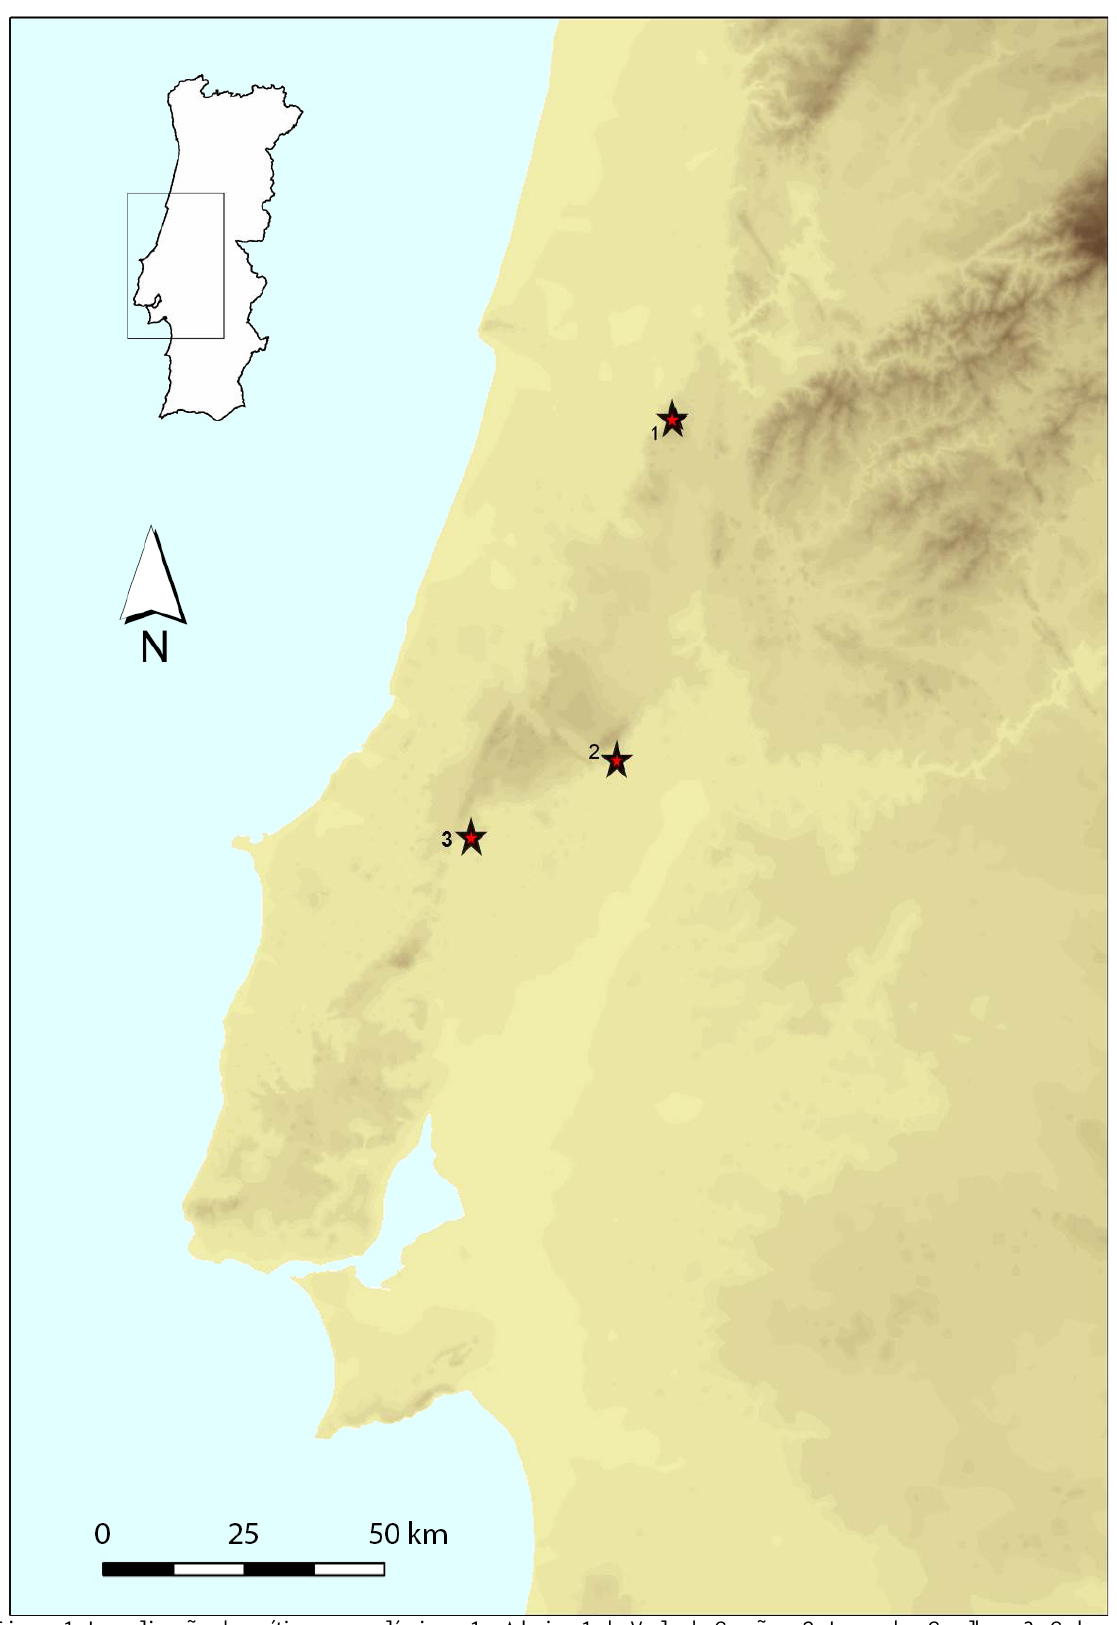
Figura 1. Localização dos sítios arqueológicos: 1 - Abrigo 1 de Vale de Covões; 2- Lapa dos Coelhos; 3- Cabeço de Porto Marinho I Figure 1. Location of the archaeological sites: 1 - Abrigo 1 de Vale de Covões; 2- Lapa dos Coelhos; 3-